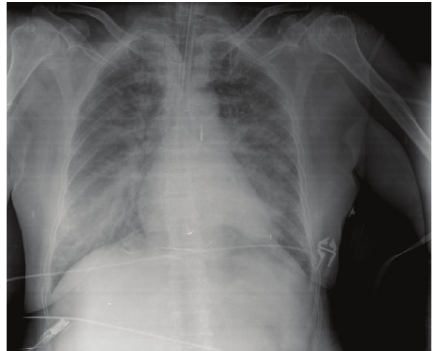
Figure 2: Chest X-ray after Angio-Seal